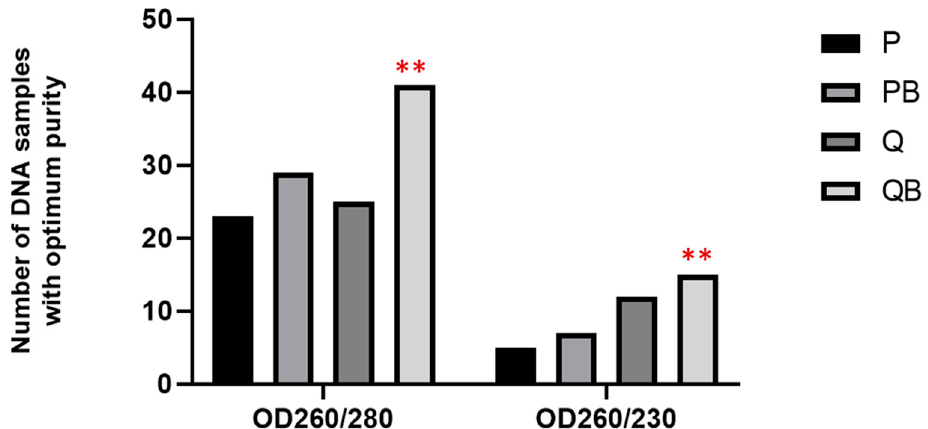
Figure 4. Comparison of the number of samples with an optimum purity of genomic DNA, extracted by the phenol-chloroform extraction method (P), the phenol-chloroform extraction method with glass beads (PB), the QIAamp Fast DNA Stool Mini Kit (Q), and the QIAamp Power Fecal Pro DNA Kit (QB). ** Statistical differences using a two-way ANOVA ( p < 0.01).